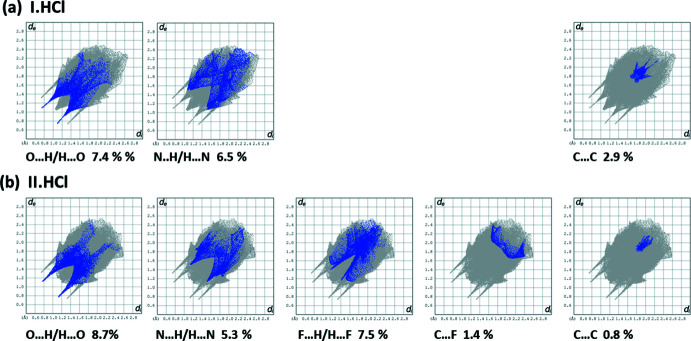
The two-dimensional fingerprint plots for compounds (a) I·HCl delineated into O⋯H/H⋯O, N⋯H/H⋯N and C⋯C, and (b) II·HCl delineated into O⋯H/H⋯O, N⋯H/H⋯N, F⋯H/H⋯F, C⋯F/F⋯C and C⋯C contacts.